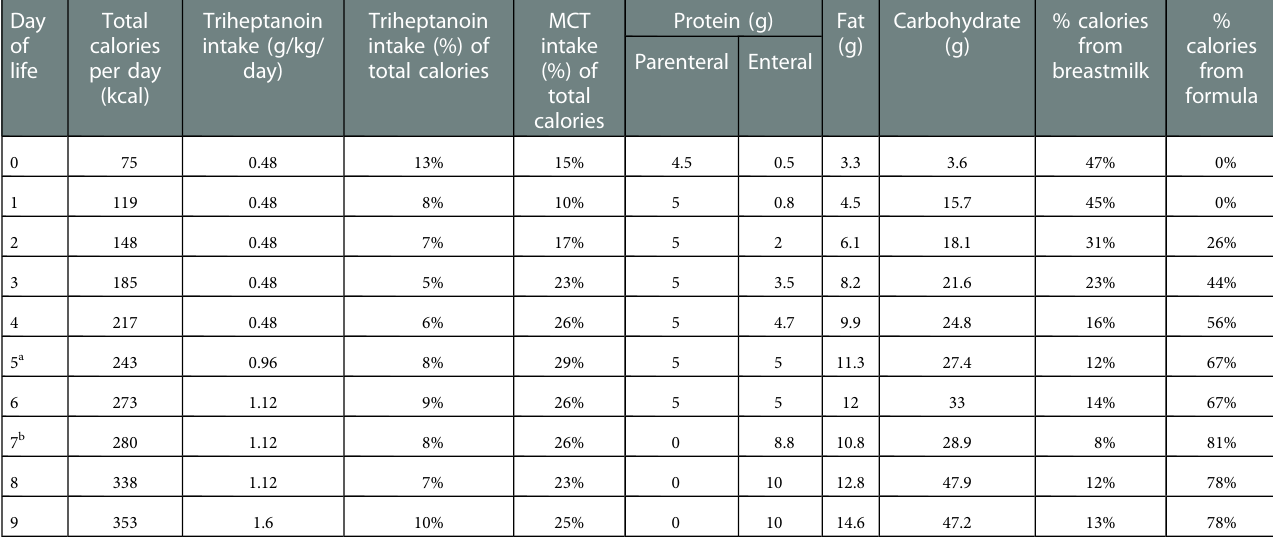
TABLE 2 Enteral feeding advancement regimen prior to developing NEC.